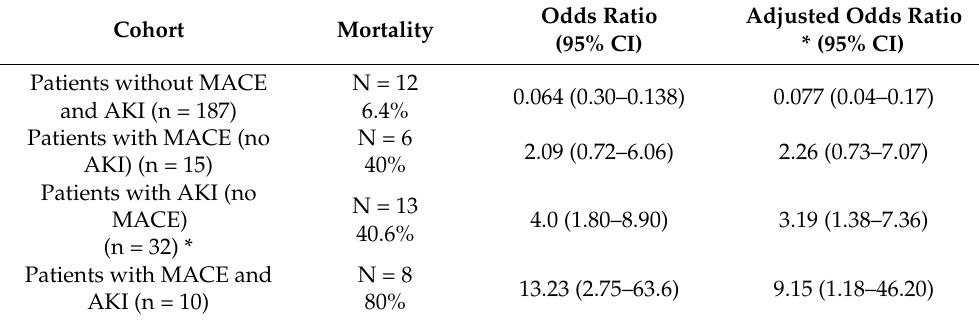
Table 4. Association between MACE, AKI and mortality in patients with severe trauma. Odds Cohort Mortality